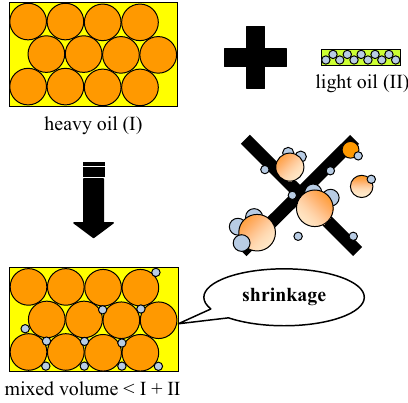
Fig. 8 Illustration of shrinkage volume from mixing of heavy and light